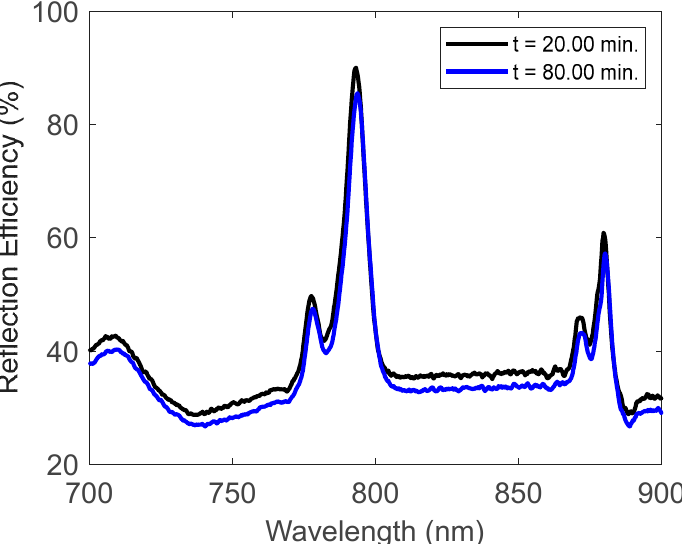
Figure 11. Experimentally measured reflection spectrum during sensor incubation in a yeast and PBS solution (8.25 × 10 5 cells/mL). The spectra displayed are at incubation times 20.00 min and at 80.00 min.